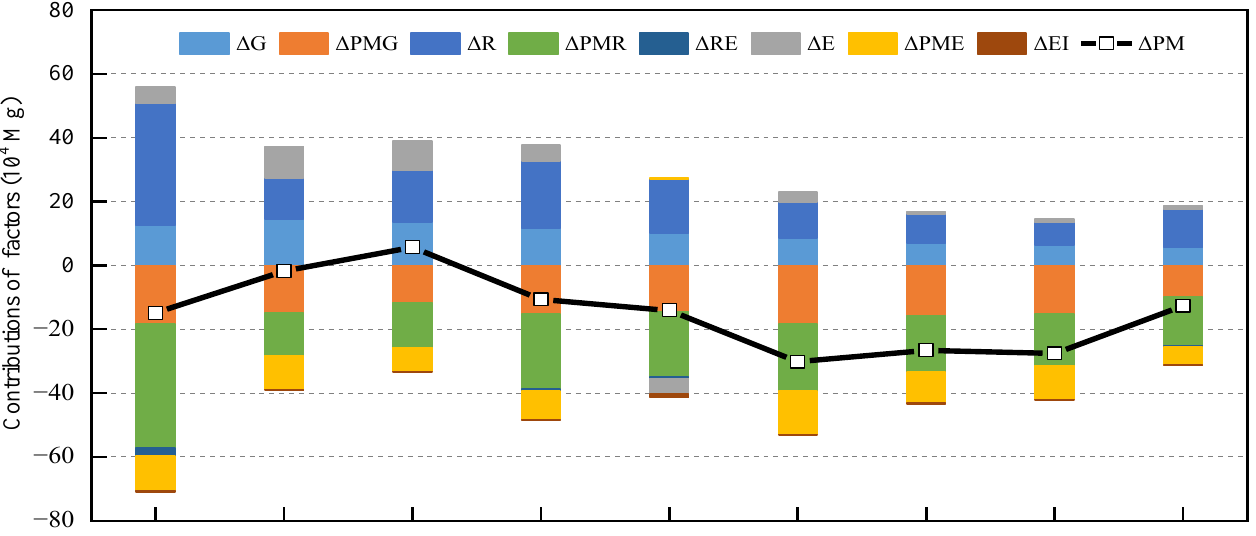
Figure A2. Decomposition results in Central China from 2008 to 2017 ( ∆ G , ∆ PMG , ∆ R , ∆ PMR , ∆ RE , ∆ E , ∆ PME and ∆ EI denote the effects of changes in GDP, emission intensity, innovation input scale, innovation input PM 2.5 intensity, innovation input efficiency, energy consumption scale, emission coefficient, and energy intensity on the changes in PM 2.5 emissions, respectively. ∆ PM indicates the changes in PM 2.5 emissions).